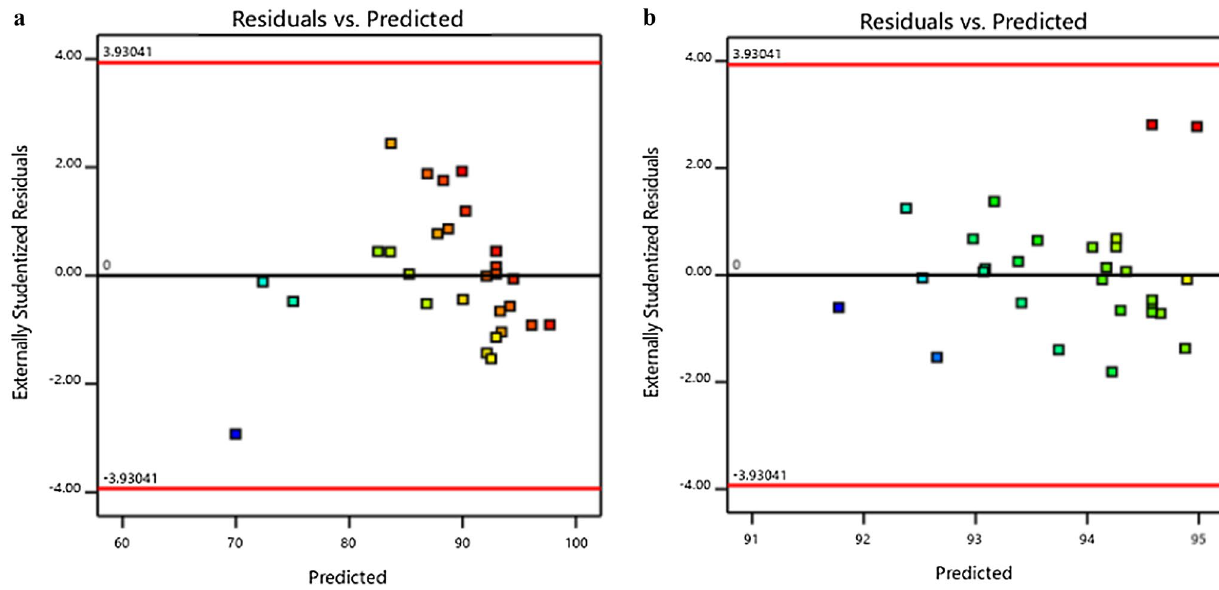
Fig. 3 Residual vs predicted plots for fluoride removal a Al-EC reactor, b Fe-EC reactor